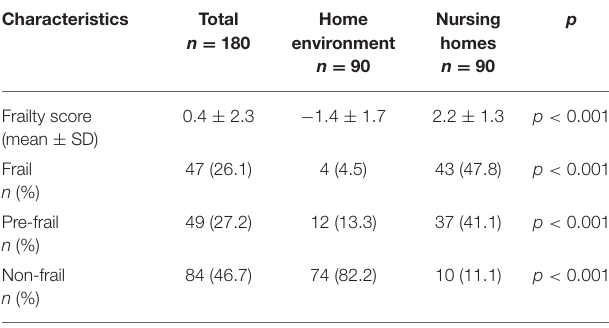
TABLE 2 | Characteristics of frailty syndrome according to the SHARE-FI in the study group ( n = 180).